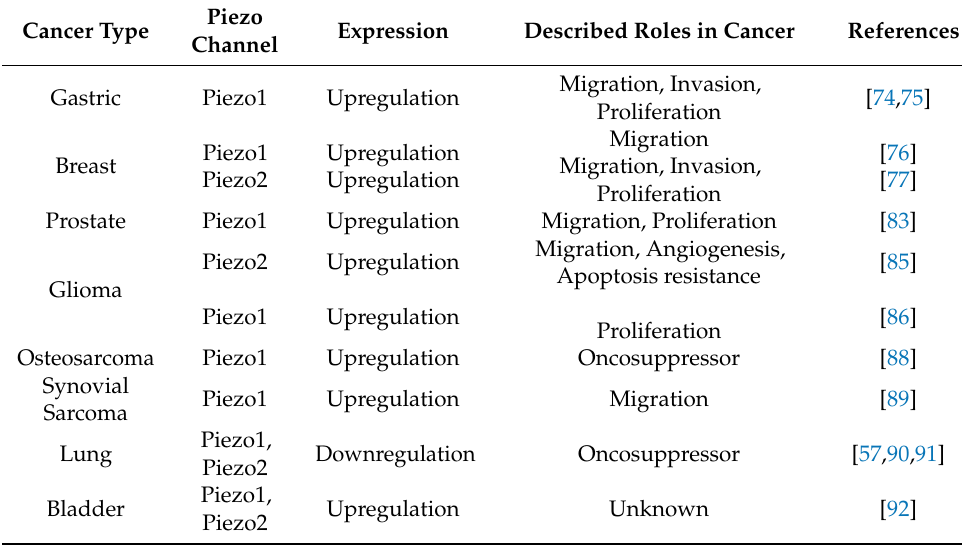
Figure 3. Tumor tissue stiffening activates Piezo1 promoting glioma aggressiveness. Tumor tissue stiffening represents the mechanical stimuli which activates Piezo1 facilitating Ca 2+ influx (blue spheres) into cytoplasm. Consequently, intracellular Ca 2+ increase, directly or indirectly, activates the integrin-focal adhesion signaling, stimulates cell proliferation and modulates the extracellular matrix remodeling. Besides, the enhanced expression of Piezo1 channels reinforces the mechanosensitivity of the tumor cells, creating a feedforward mechanism which leads to a further glioma progression. Adapted from reference [86]. Created with BioRender.com. Table 1. Expression and roles of Piezo channels in